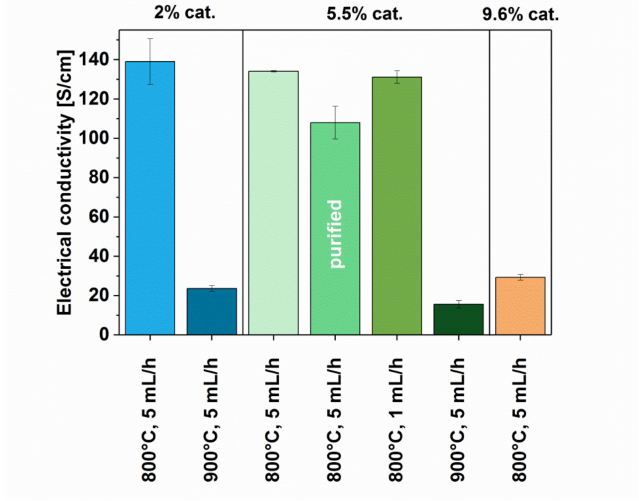
Figure 8. Electrical conductivity of MWCNTs synthesized using di ff erent parameters (with and without